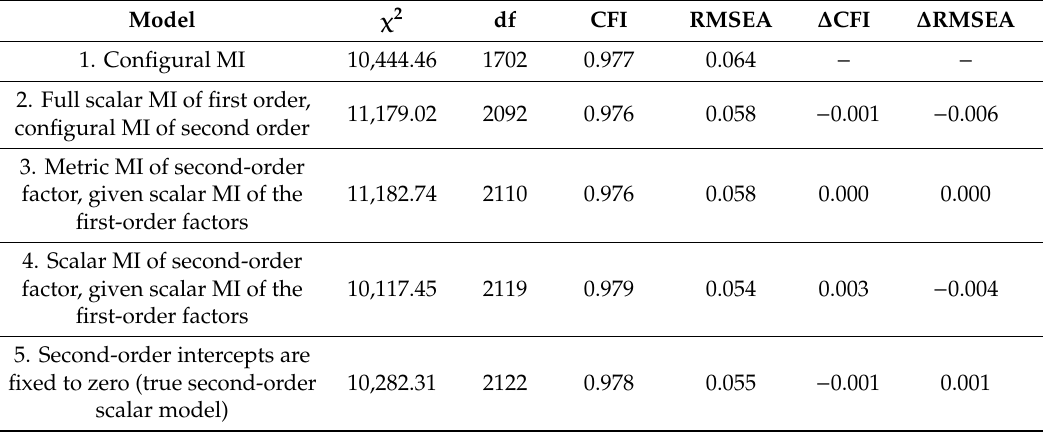
Table 3. Fit statistics for the models tested to investigate invariance across countries.